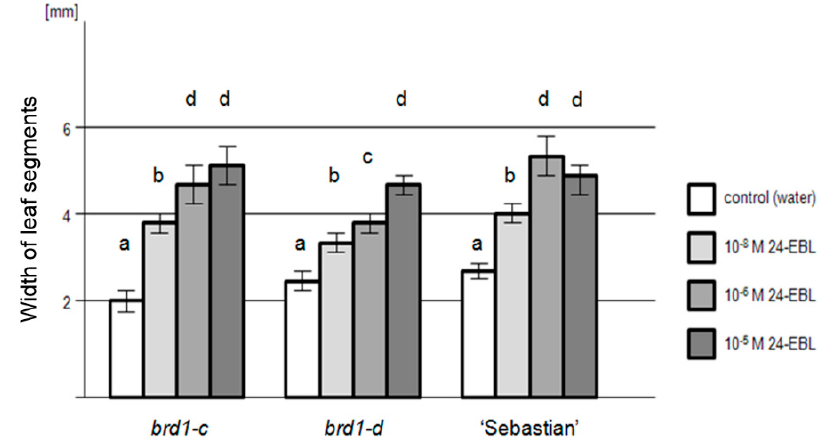
Figure 6. Results of the etiolation test for the identified mutants with the brd1-c and brd1-d alleles and the parent variety “Sebastian” (reference). Fifty seedlings per genotype were analyzed with three replications of the experiment. Values (seedling lengths) analyzed for each genotype were compared between the growth conditions (darkness vs. light). In the brd1-c and brd1-d mutants length of seedlings grown in the darkness is very similar to the length of those grown in the light (both mutants show lack of enhanced elongation during growth in the darkness), although the brd1-c seedlings were significantly longer than the brd1-d plants in the corresponding growth conditions. On the contrary, seedlings of the “Sebastian” variety grown in the darkness are significantly longer than seedlings of this genotype grown in the light. Error bars represent standard deviation. The differences between values denoted by the same letter are not statistically significant ( p ≤ 0.05).